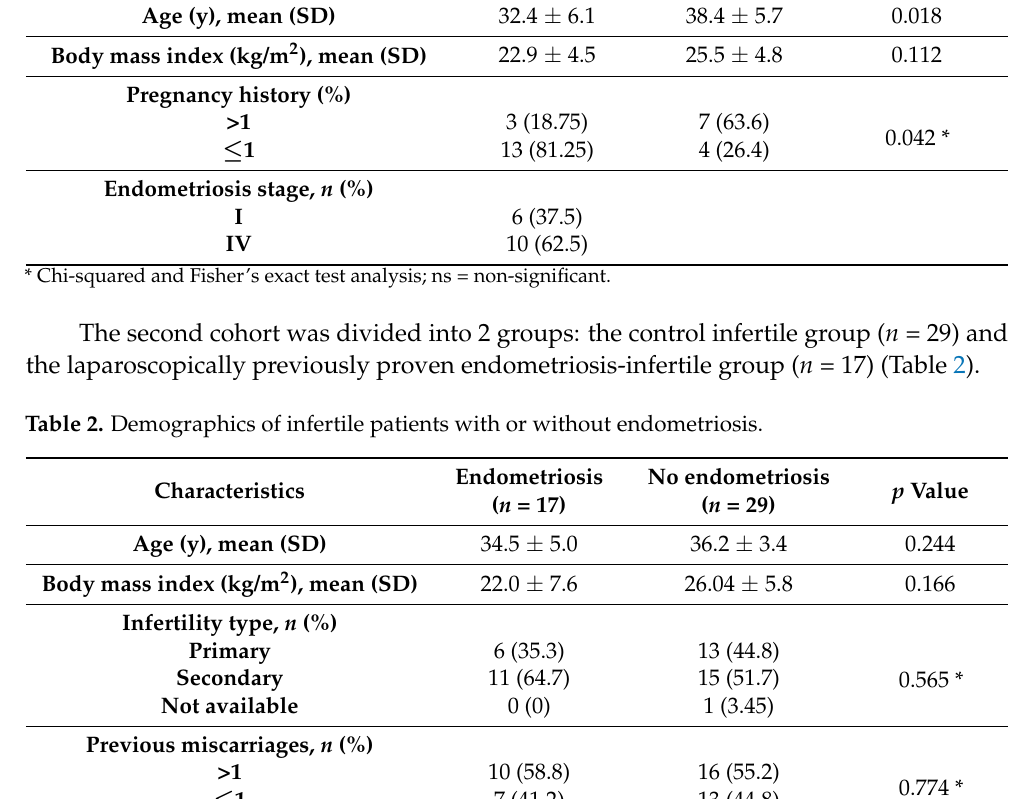
Table 1. Demographics of patients who underwent laparoscopy. Characteristics